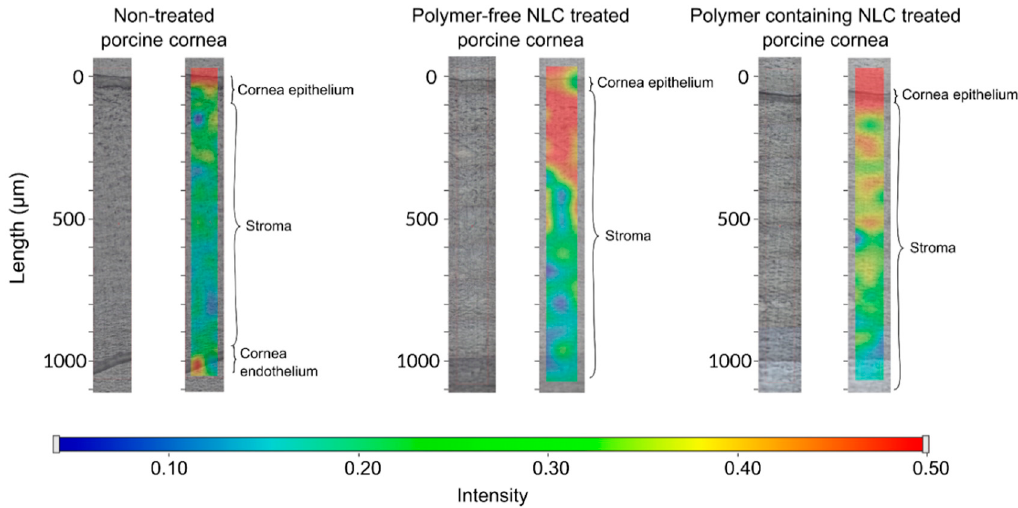
Figure 16. The Raman correlation map of NLC6 and the polymer-free version of the composition.